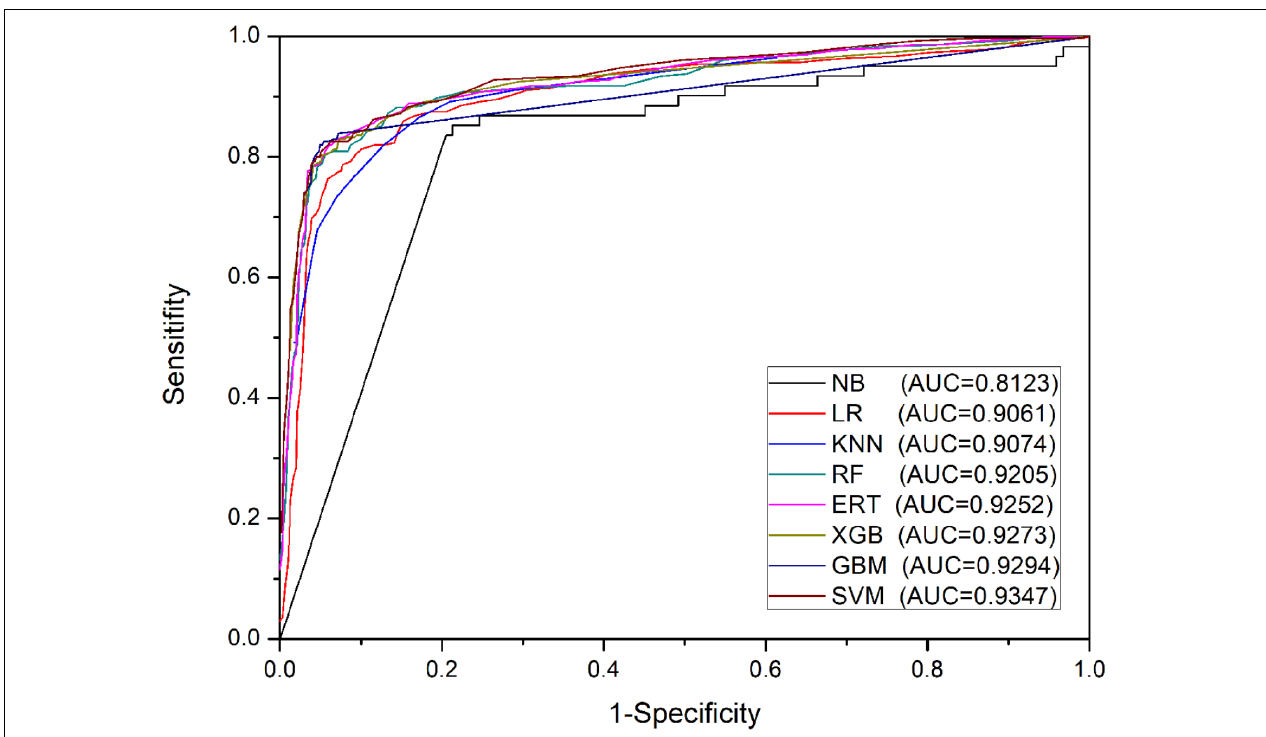
FIGURE 3 | ROC curves of base-classifiers in the first stage on Train-915 dataset using 5-fold cross validation.